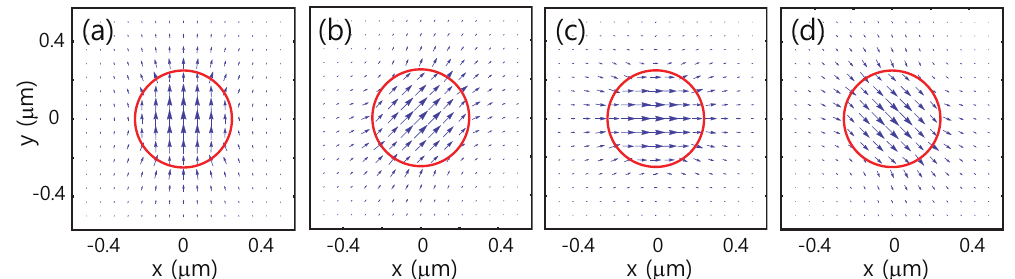
Figure 6. Vector field plots of the electric component perpendicular to the fiber axis in the fundamental HE 11 mode for rotating polarization at ( a ) t = 0, ( b ) π /4 ω , ( c ) 2 π /4 ω , ( d ) 3 π /4 ω under the conditions of a = 250 nm and λ = 780 nm.